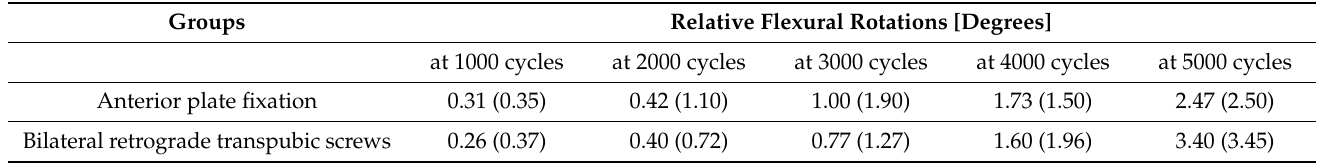
Table 3. Relative flexural rotations in the study groups after 1000, 2000, 3000, 4000 and 5000 cycles, presented in terms of median and interquartile range (the latter in brackets).